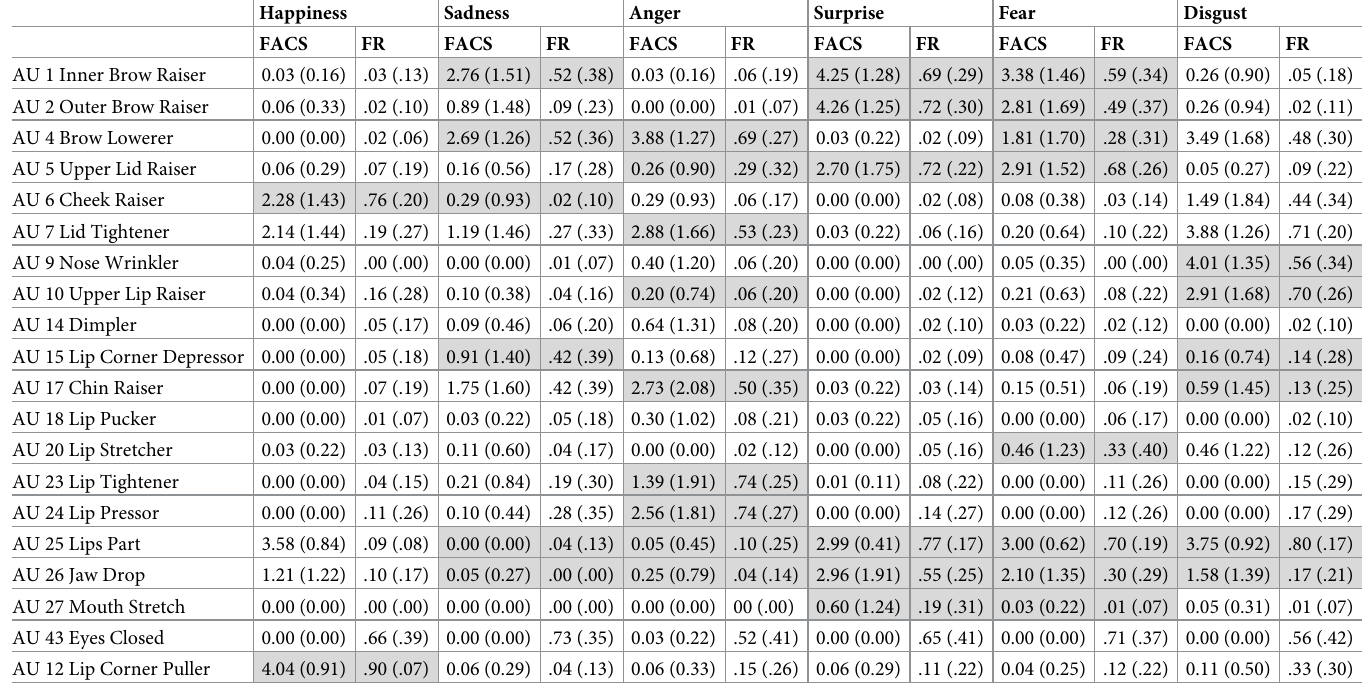
Table 3. Mean (standard deviation) values for Facial Action Coding System (FACS) and FaceReader (FR) coding of Action Units (AU). Happiness Sadness